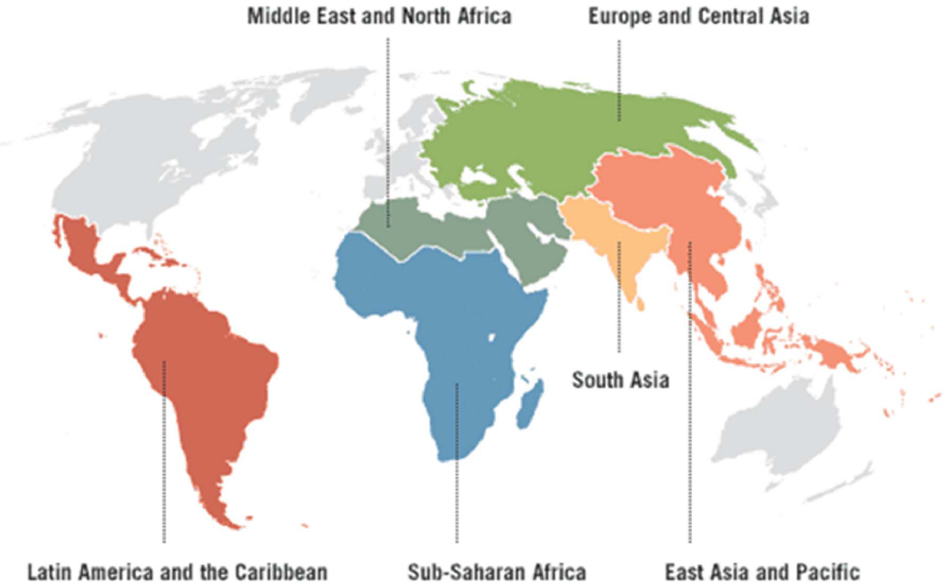
Figure 1. World Bank regions. Six of the seven World Bank regions are organized according to geography. The seventh region, the High Income region (shown here in white) includes North America, Japan, Taiwan, Australia, New Zealand, and European countries–based on a gross national income greater than $ 12 276 per capita in 2010. Figure adapted from World Bank Regions, Disease Control Priorities Project. www.dcp2.org/page/ main/BrowseCountries.html.